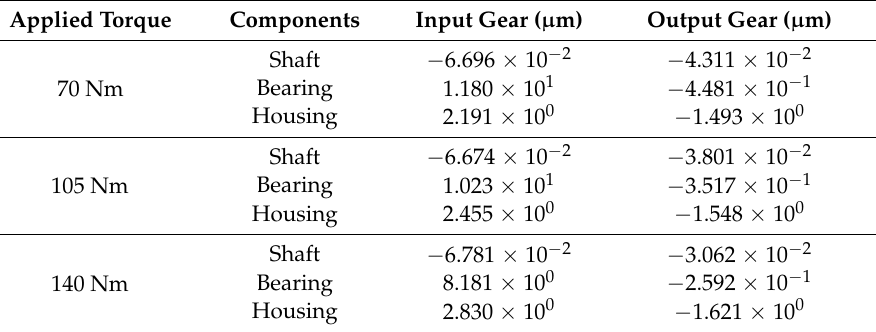
Table 4. Gear mesh misalignments, F β X , of the components in relation to applied torque when using static stiffness ( f G = 0 Hz).